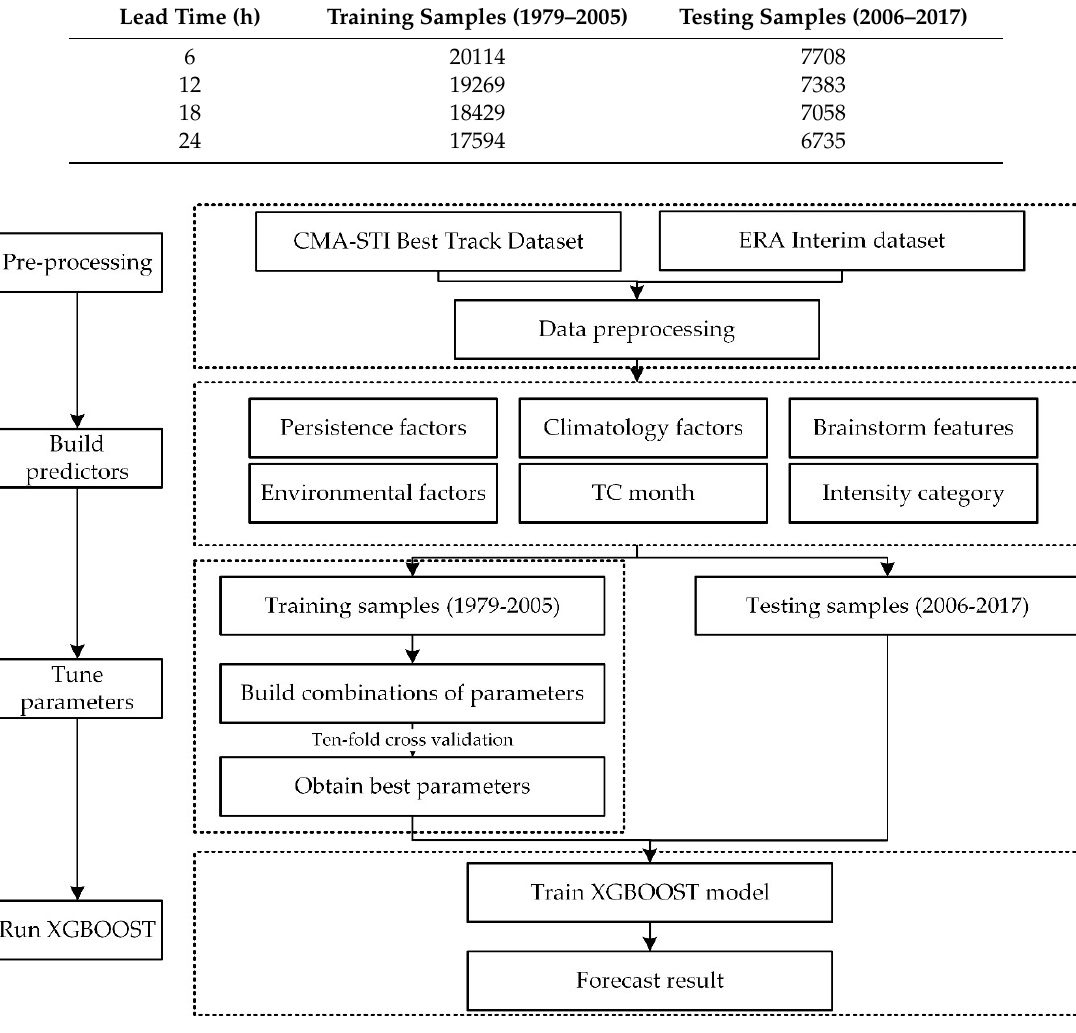
Figure 1. Flow-process diagram.